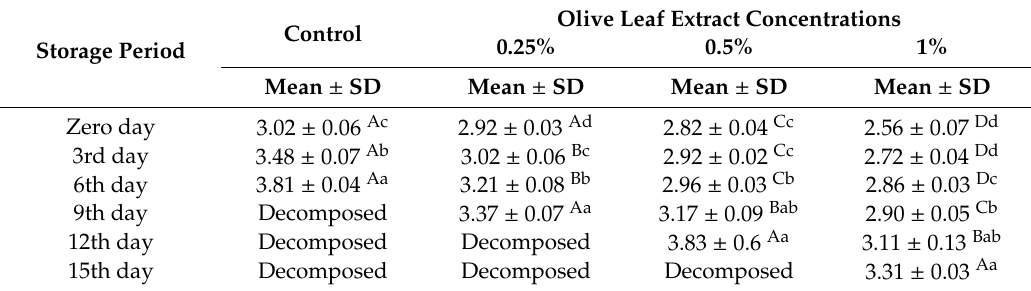
Table 7. Pattern of the Enterobacteriaceae count (log10 cfu / g) in poultry meat treated with di ff erent concentrations of olive leaf extract during the chilling storage period at 4 ± 1 ◦ C (mean ± standard deviation